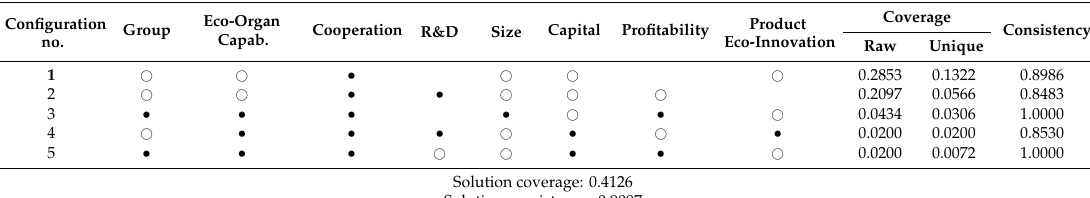
Table 8. Model predicting the development of internal process eco-innovations in agri-food companies. Configuration